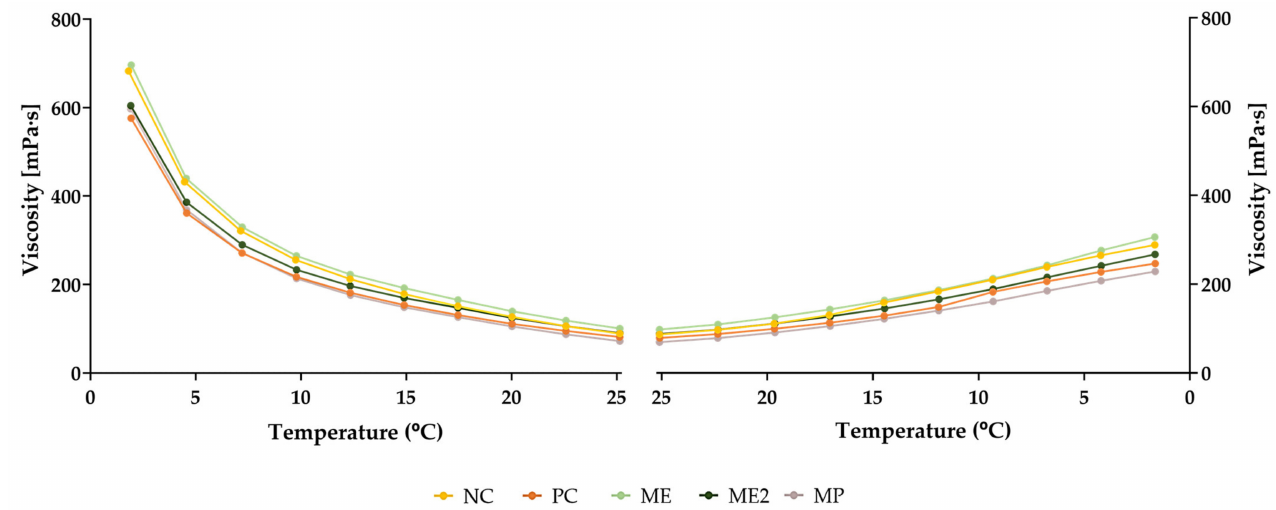
Figure 6. Viscosity variation of the yoghurts as a function of the temperature, after production (t 0 ). NC—yoghurt with no additives (negative control); PC—yoghurt with sorbic acid (positive control); ME—yoghurt with 1 g/L of M. oleifera extract; ME2—yoghurt with 2 g/L of M. oleifera extract; MP—yoghurt with 2.9 g/L of M. oleifera leaf